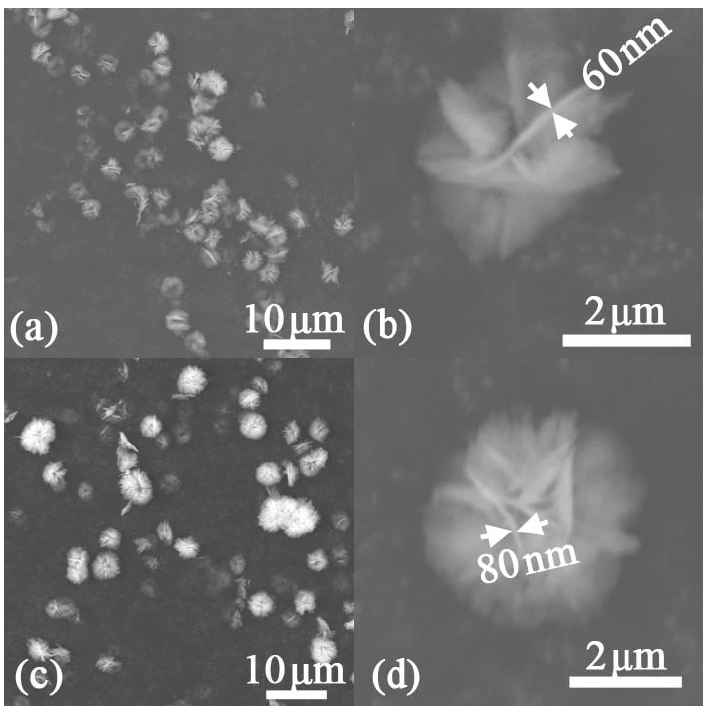
Figure 2. (a) SEM image and (b) magnified SEM image of Co(OH) magnified SEM image of Co(OH)